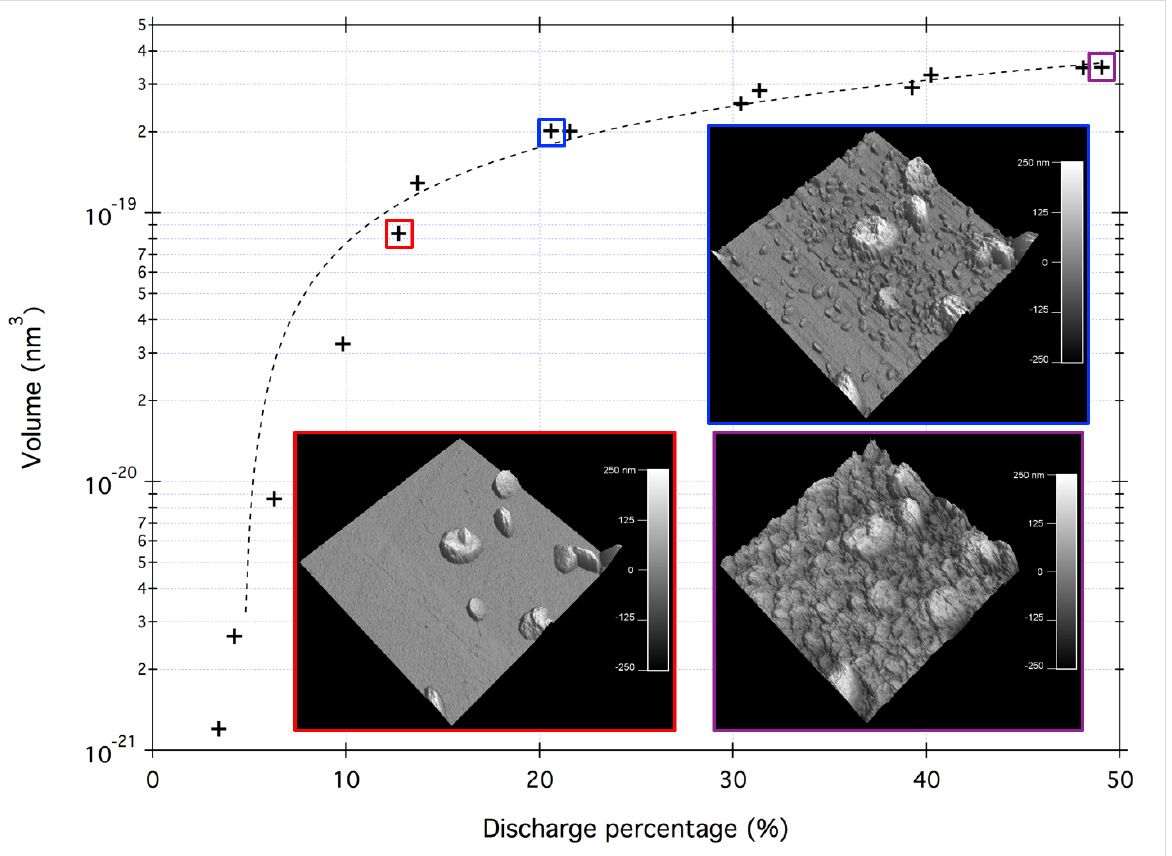
Figure 5: 3D volume analysis of electrochemical deposits formed on the glassy carbon surface in Figure 4. The red inset shows a 3D view of the sur- face at ≈ 12% discharge capacity. The nanostructures deposited on the surface exhibit platelet morphology. An even finer nanostructure was ob- served beyond the platelet morphology. The blue inset shows a 3D view of the surface at ≈ 22% discharge capacity. In addition to the nanostructures deposited on the surface, much smaller hemispherical nanostructures appear to nucleate and further grow. The purple inset shows the morphology at 100%